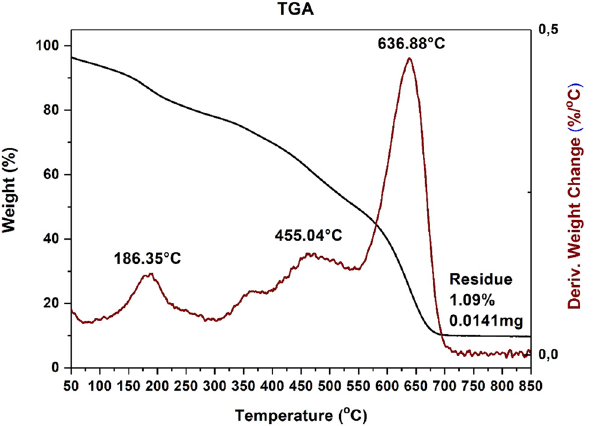
Figure 11: TGA thermogram for modi fi ed CNTs after acylation with rhodamine B.